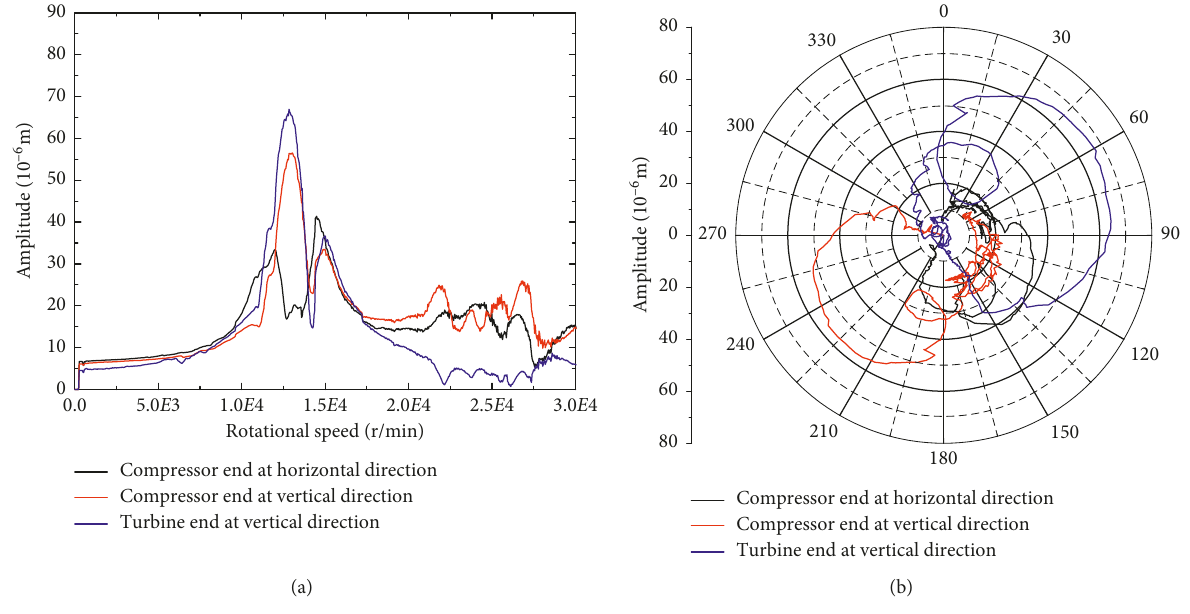
Figure 17: Bode diagram in the acceleration process. (a) Amplitude response. (b) Bode diagram.